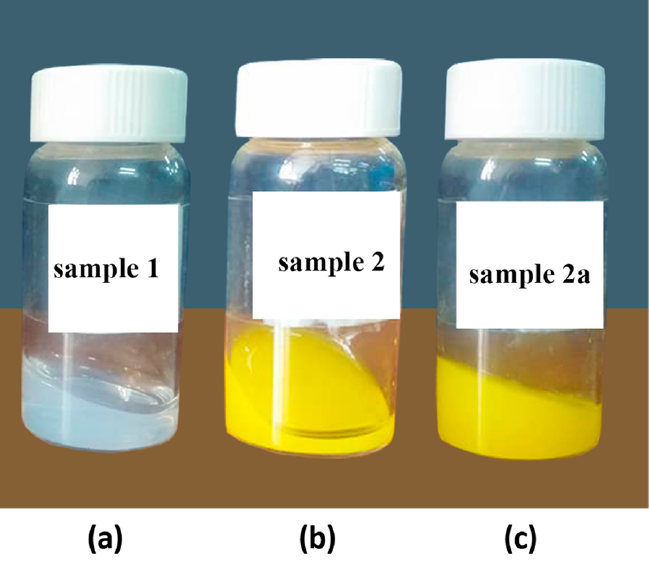
Figure 1. Collagen gels formed at pH 7.5 in the absence of riboflavin ( a ) and in the presence of riboflavin prior to ( b ) and after ( c ) UVA irradiation.